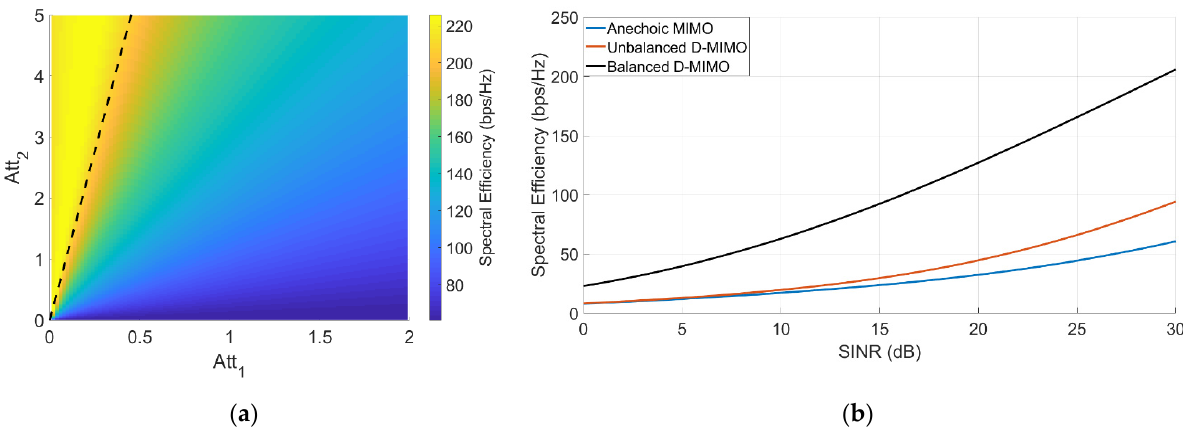
Figure 8. ( a ) Spectral efficiency (D-MIMO 66 × 25) for a parametric sweep of Att 1 and Att 2 and ( b ) spectral efficiency for the anechoic MIMO (blue line), unbalanced D-MIMO (red line) and balanced MIMO (black line).